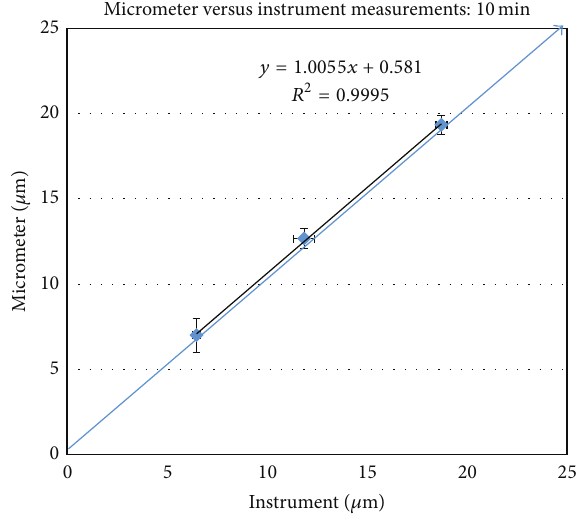
Figure 4: Cuspal deformation of Al blocks measured by bench-top micrometer versus LVDT instrument as a result of polymerization stress.